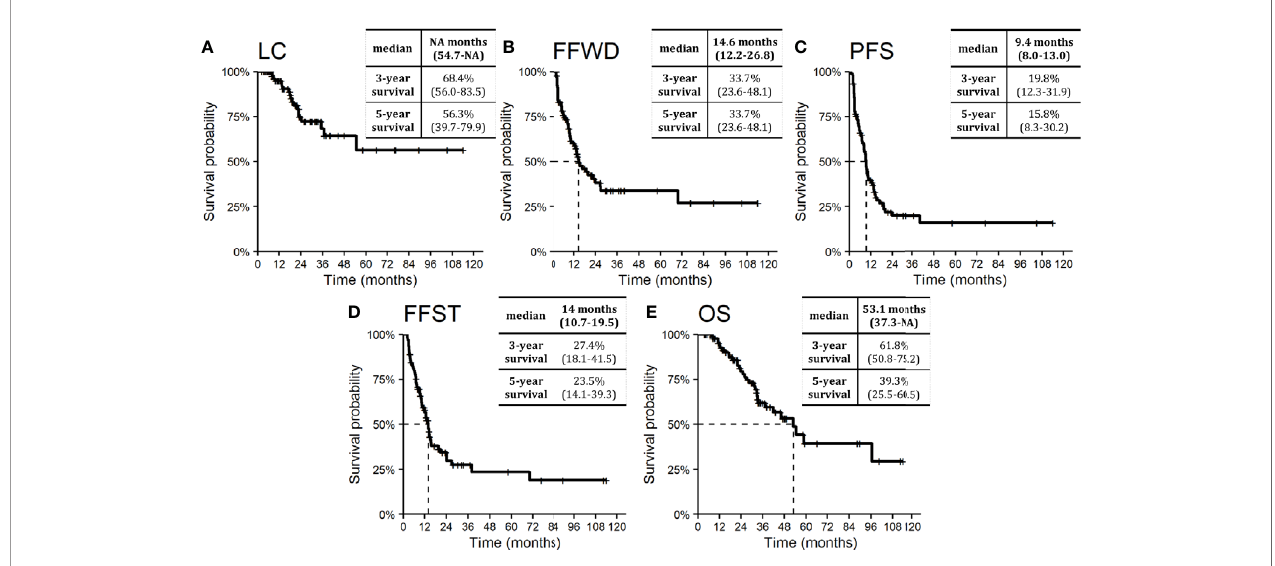
FIGURE 2 | Kaplan – Meier curves for (A) local control, (B) freedom from widespread dissemination, (C) progression-free survival, (D) freedom from systematic treatment, and (E) overall survival. Dashed lines represent medians. Nested tables include selected characteristics with 95% con fi dence intervals. NA, Not